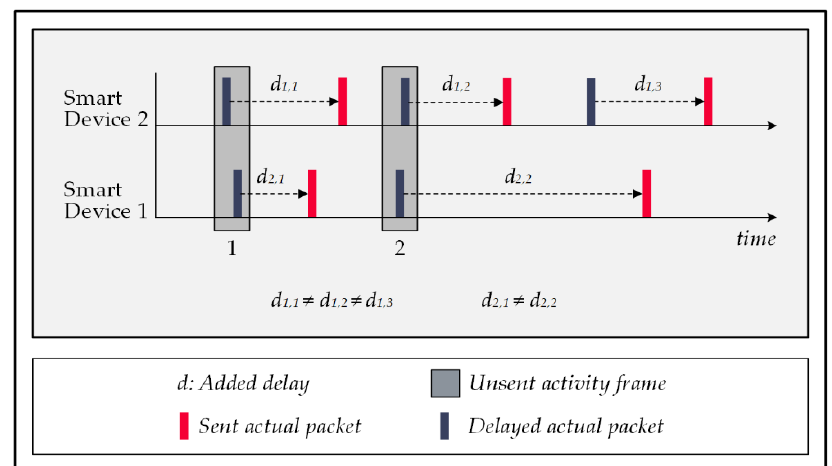
Figure 7. Temporal manipulation in forwarding actual data packets.